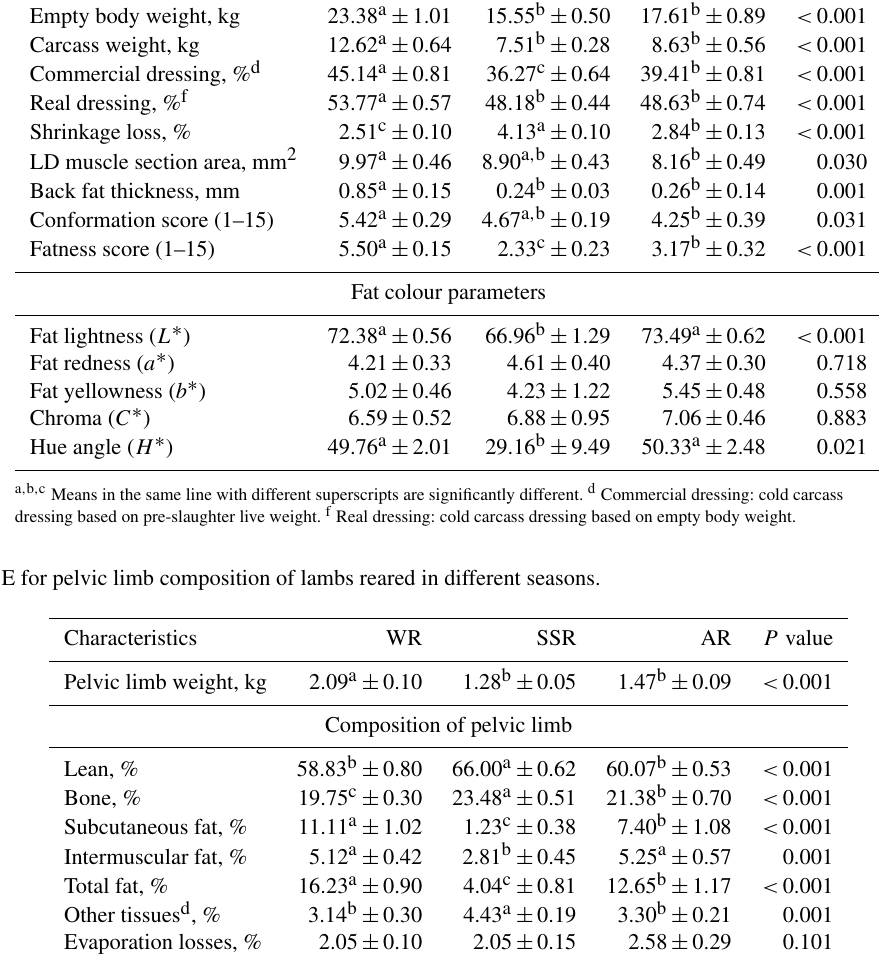
Table 2. Means ± SE for certain carcass quality characteristics and fat colour parameters of lambs reared in different seasons. Characteristics